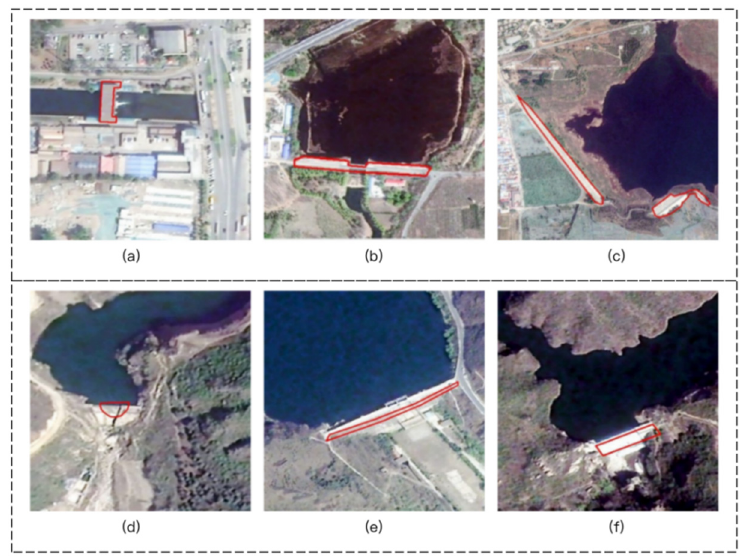
Figure 20. Examples of OSM Dams overlapped by satellite images. ( a – c ) Well-matched dam masks; ( d – f ) poorly matched dam masks.